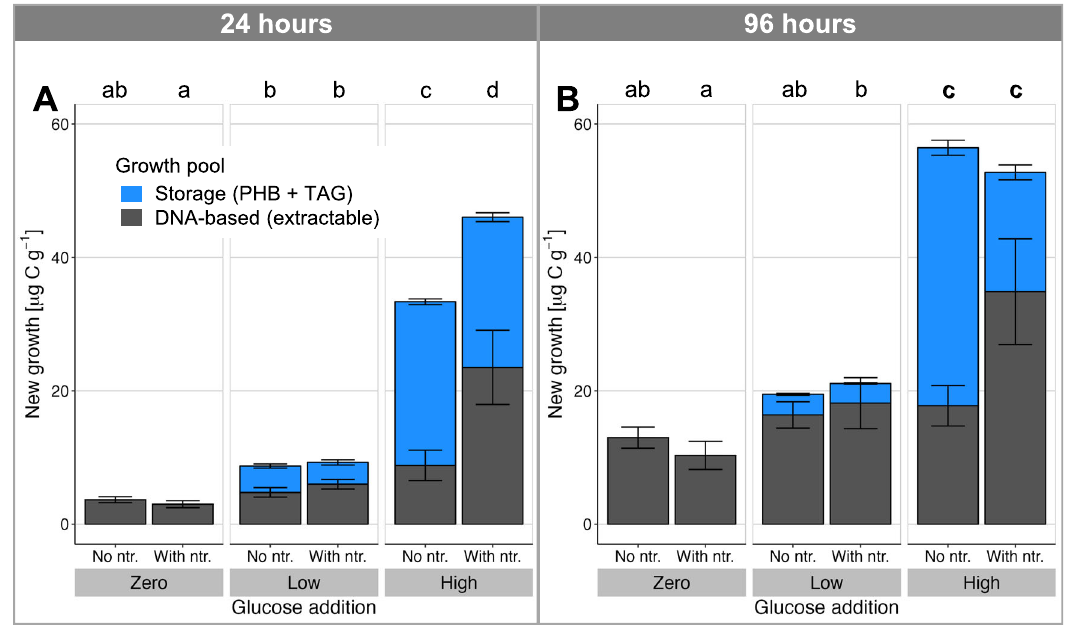
Fig. 4 | Comparison of new storage biosynthesis with DNA-based microbial growth reveals storage as a substantial, overlooked component of biomass growthinsoil. 13 C-labelledstoragecompoundsynthesis(PHBandTAGs)andDNA- based growth (incorporation of 18 O) were measured in soil 24 A and 96h B after addition of a readily degradable, 13 C-labelled carbon source (glucose at 0, 90, and